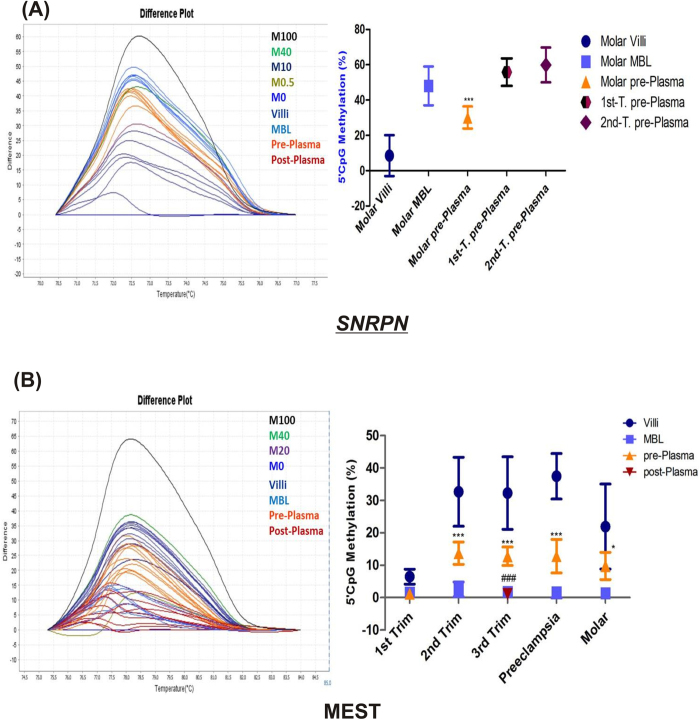
Evaluation of SNRPN and MEST as a fetal DNA epigenetic marker.(A) SNRPN and (B) MEST, each figure represents a difference plot showing methylation standards in different colors (M100%–M0%, which stands for DNA methylation standards with 100 to 0% methylation) normalized to the 0%-methylated standard DNA and few representative samples of each group and a graphical representation of % CpG methylation detected within placental villous samples, maternal blood leukocytes (MBL), maternal plasma samples obtained pre- obstetric procedure (pre-Plasma) and post-delivery (post-Plasma, only in case of third trimester group) from each group. The data is presented as mean percentage methylation ± SEM, n = 30 per group. *p < 0.05, ***p < 0.001 w.r.t the respective maternal blood leukocytes and ###p < 0.001 w.r.t the pre-plasma.